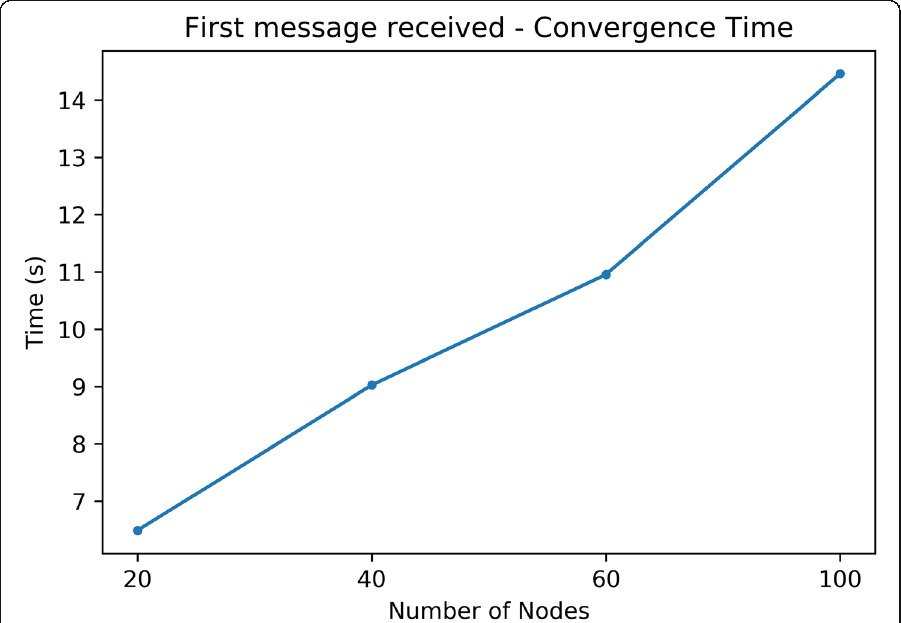
Fig. 8 RPL convergence time. This figure shows the evolution of the convergence time of the RPL protocol for different scenarios and with a different number of nodes (up to 100